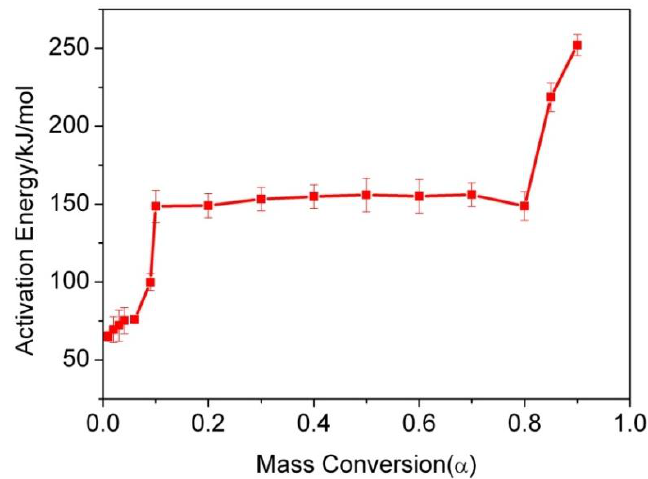
Figure 7. Dependence of the activation energy on mass conversion, as calculated with the Ozawa